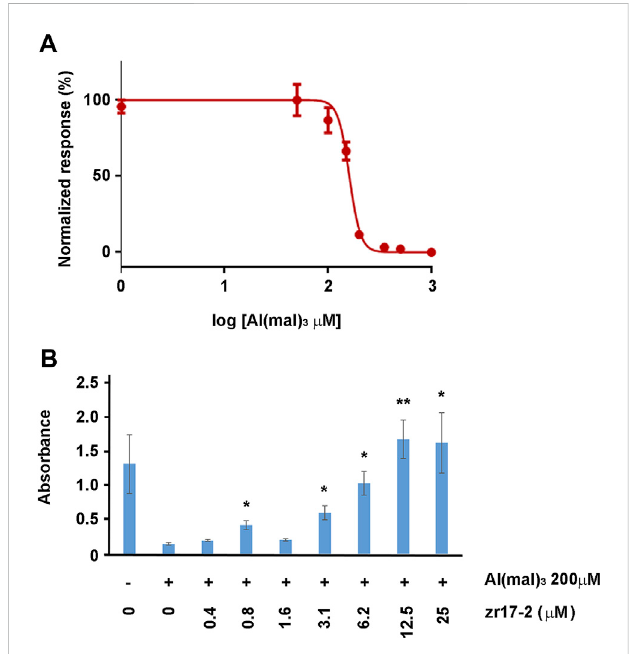
FIGURE 6 R28cellsresponsestoAl(mal) 3 andzr17-2.First,atoxicityassaywas performedtodeterminetheIC 50 ofAl(mal) 3 onR28 (A) .Then,cellswere exposed to 200 µM Al (mal) 3 and increasing concentrations of zr17-2. Aluminum maltolatedrastically reduced cellnumberwhereas zr17- 2signi fi cantlypreventedcelldeathinadose-dependentfashion (B) .Bars represent the mean ± SD of all wells (n = 8 per experimental condition). Asterisks represent statistically signi fi cant differences with the Al (mal) 3 treatment (second bar) (ANOVA). *: p < 0.05; **: p <